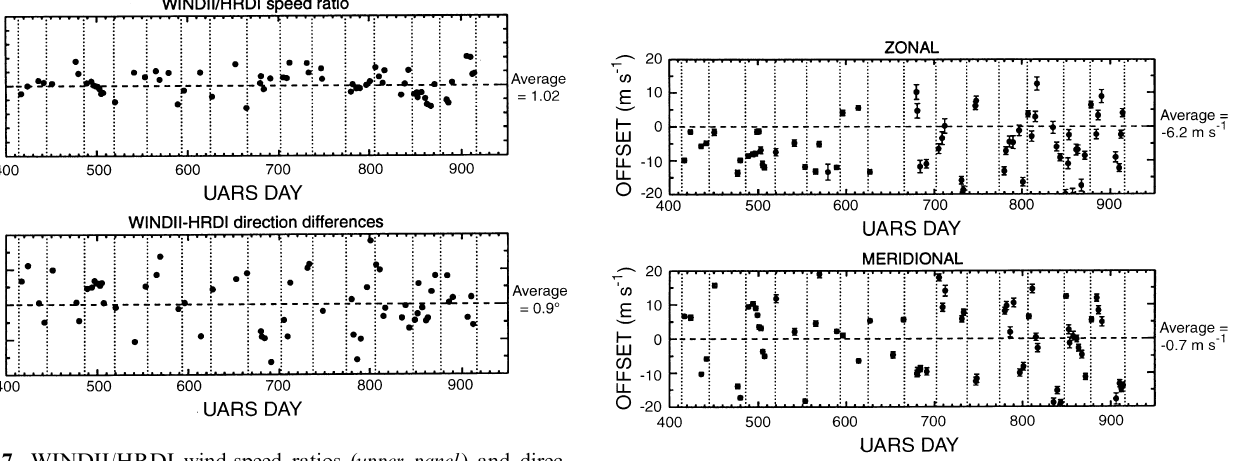
Fig. 9. Same as Fig. 6, but for the intercepts obtained from the